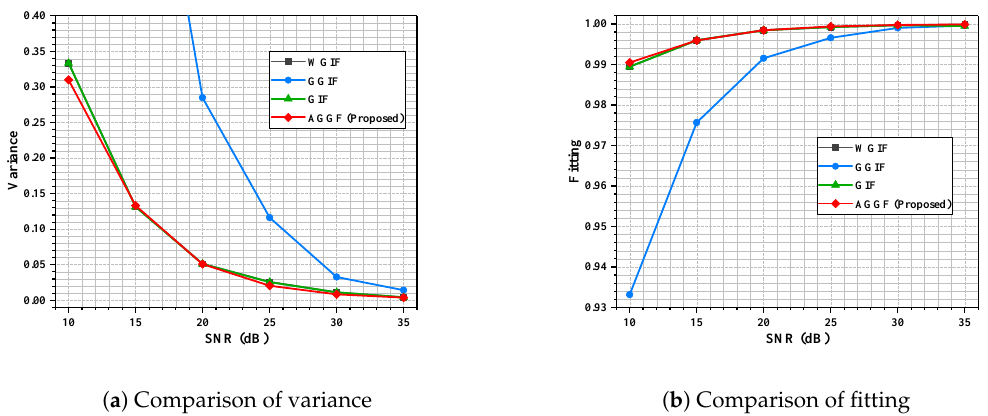
Figure 9. Indoor experiment, f p = 5 GHz; influence of SNR on filtering effect.